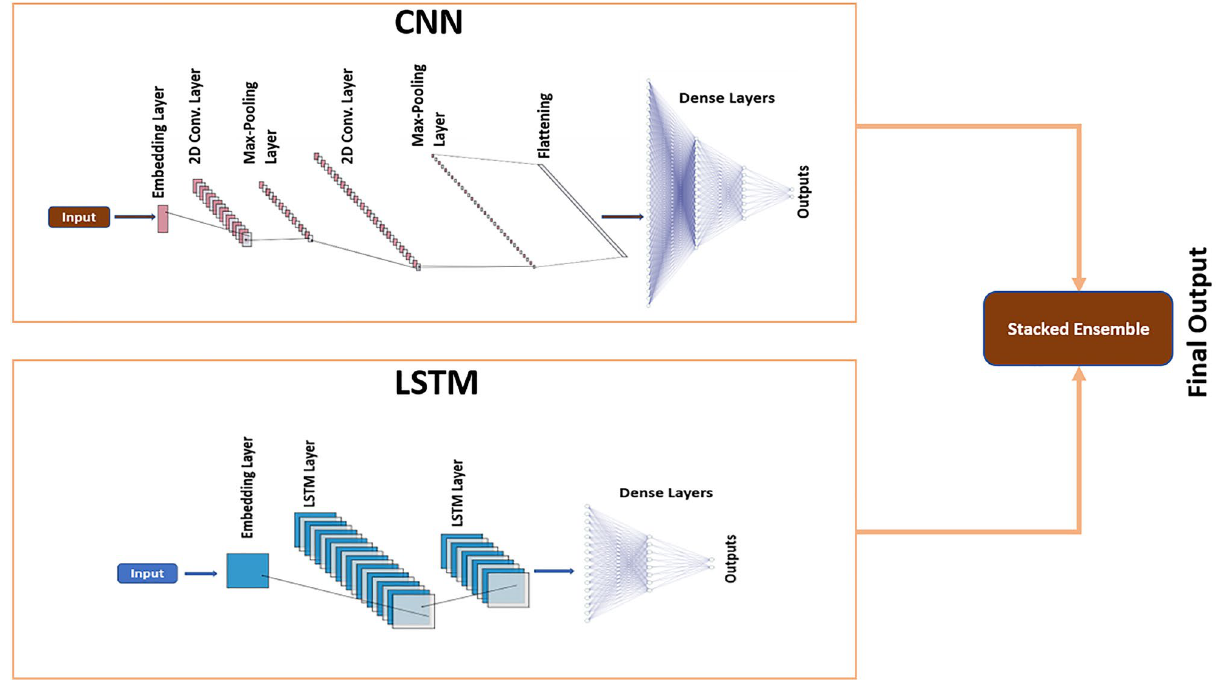
Figure 2. Ensemble model Chlamy-EnPhosSite combining CNN and LSTM models with stacking. Models Sensitivity Specificity Accuracy AUC MCC